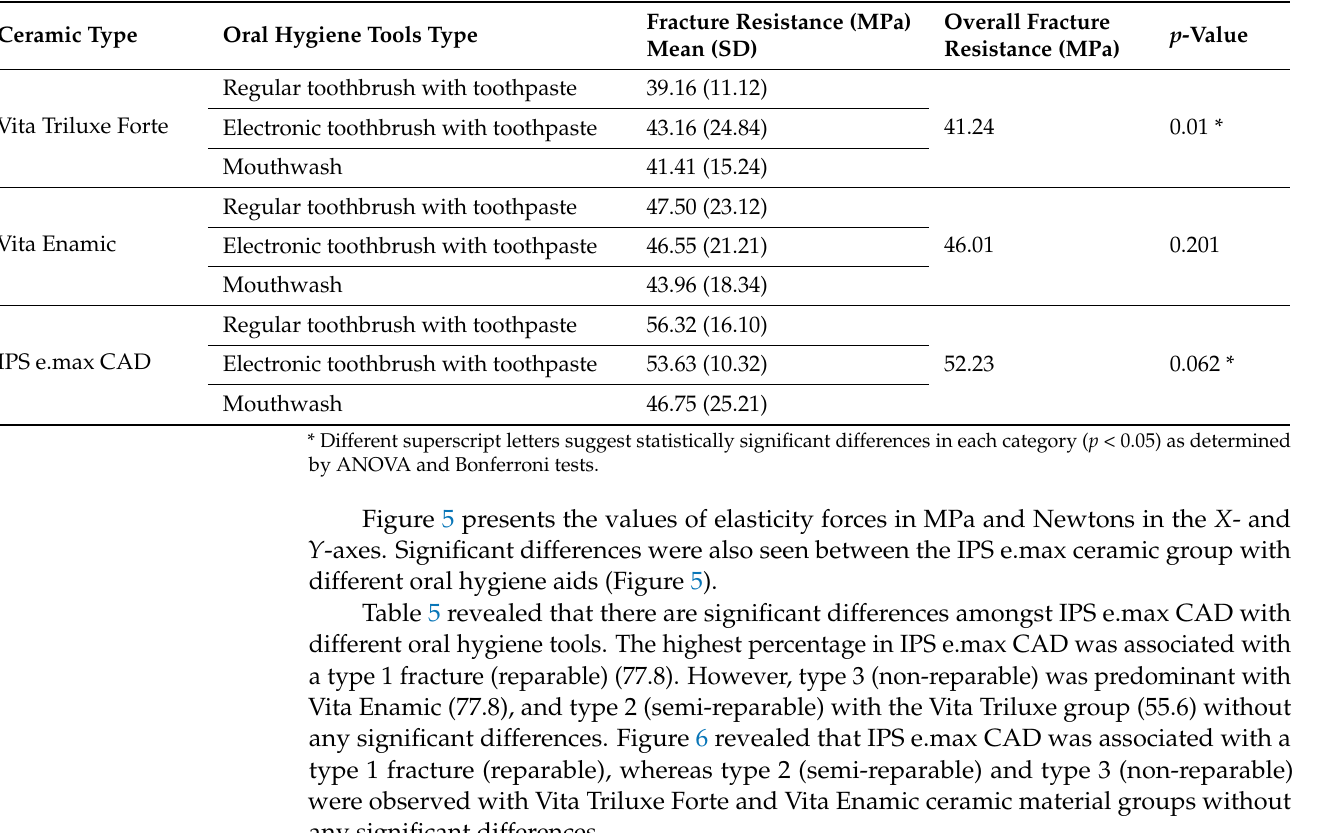
Table 4. Comparison of modules of elasticity forces with different ceramic materials.